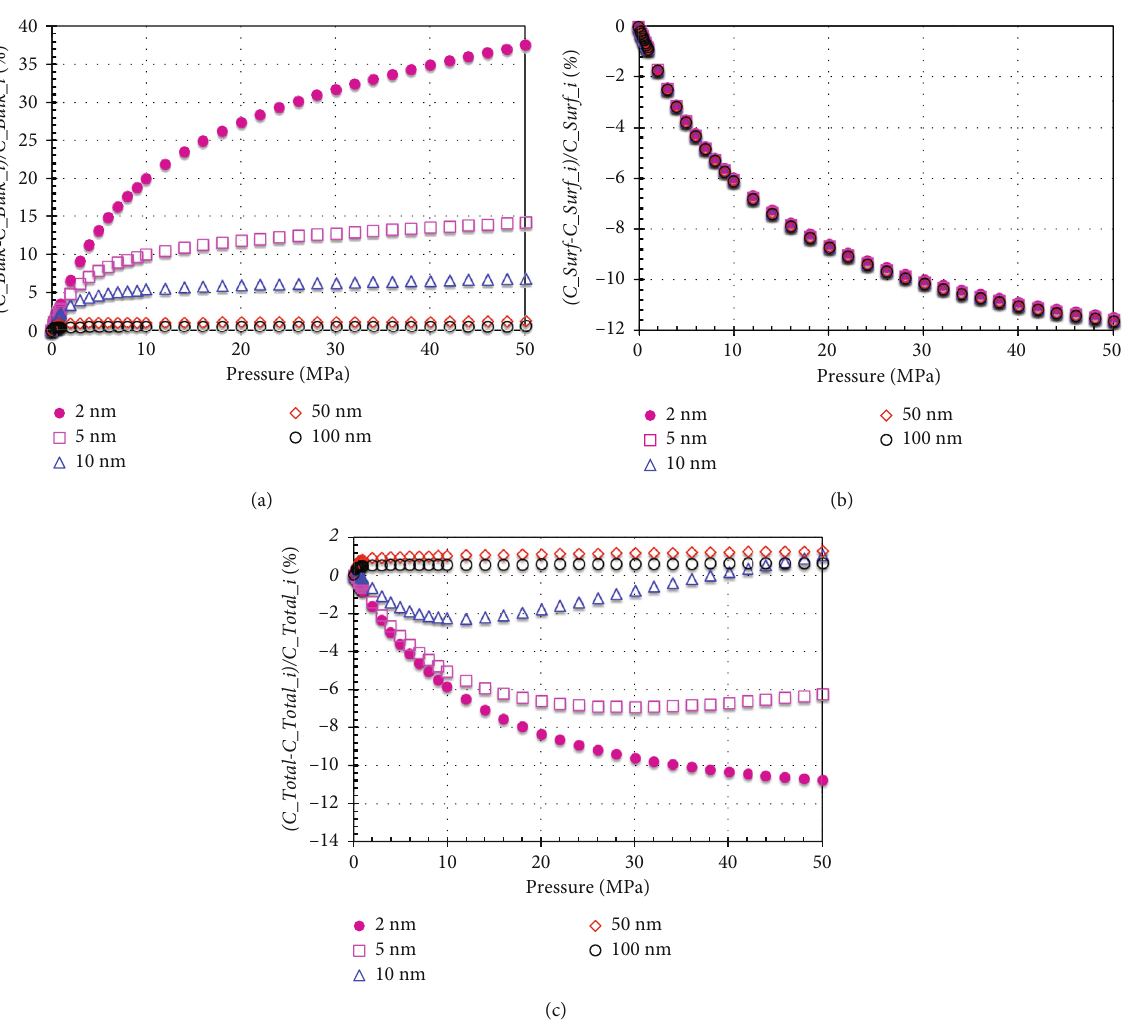
Figure 7: Deviation caused by the real gas e ff ect: (a) Bulk-like gas conductance; (b) Surface di ff usion; (c) Total gas